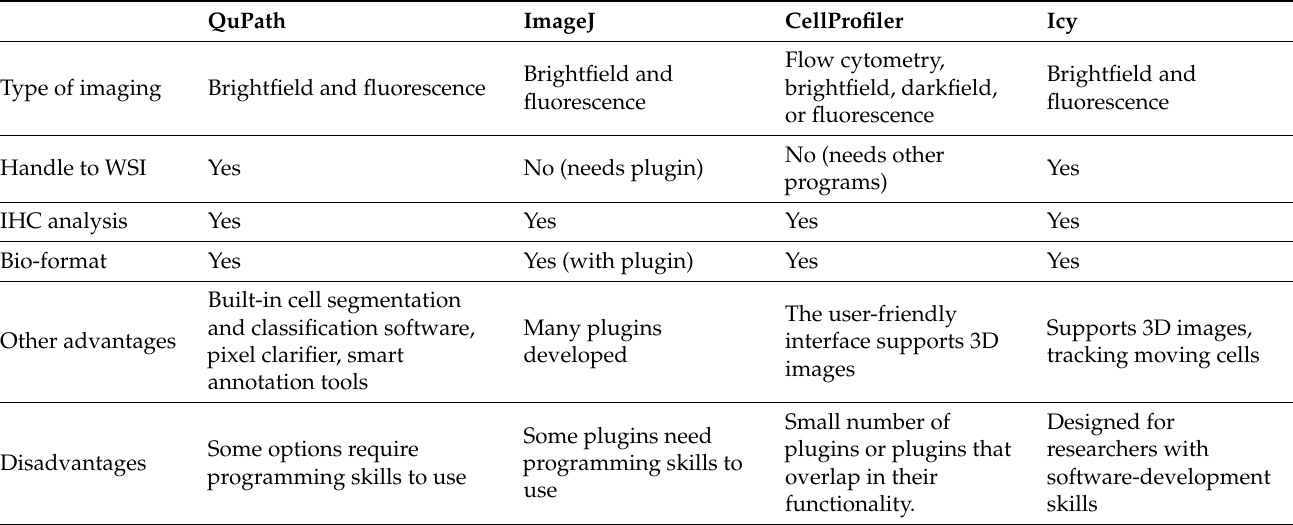
Table 2. The characteristics of the most popular software used for image analysis based on